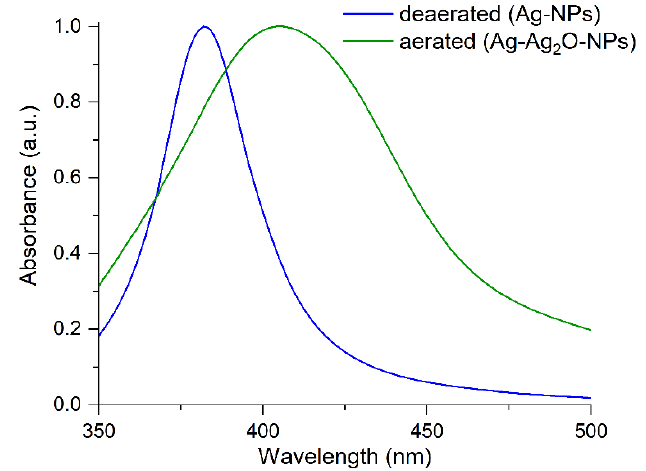
Figure 3. Absorbance of silver nanoparticles obtained in deaerated (Ag-NPs) and in aerated (Ag- Ag 2 O-NPs) solutions.